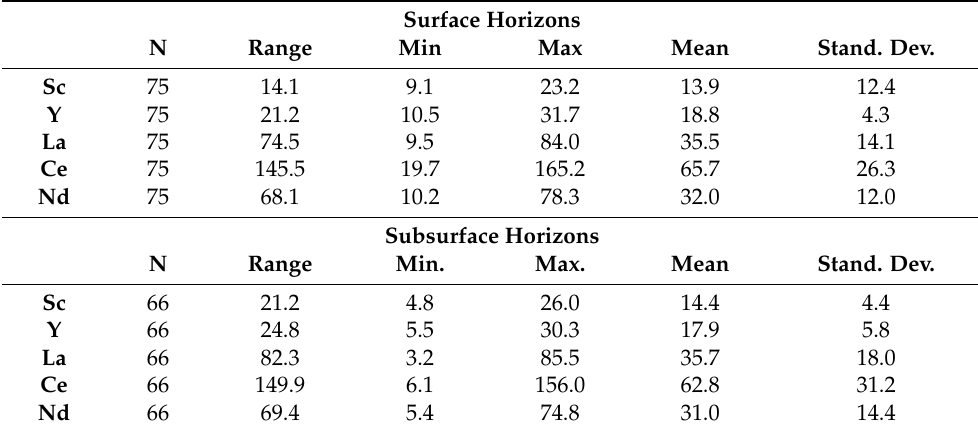
Table 1. Mean contents (mg · kg –1 ) and other statistical data for REEs elements in vineyard soils of Campo de Calatrava. N = number of